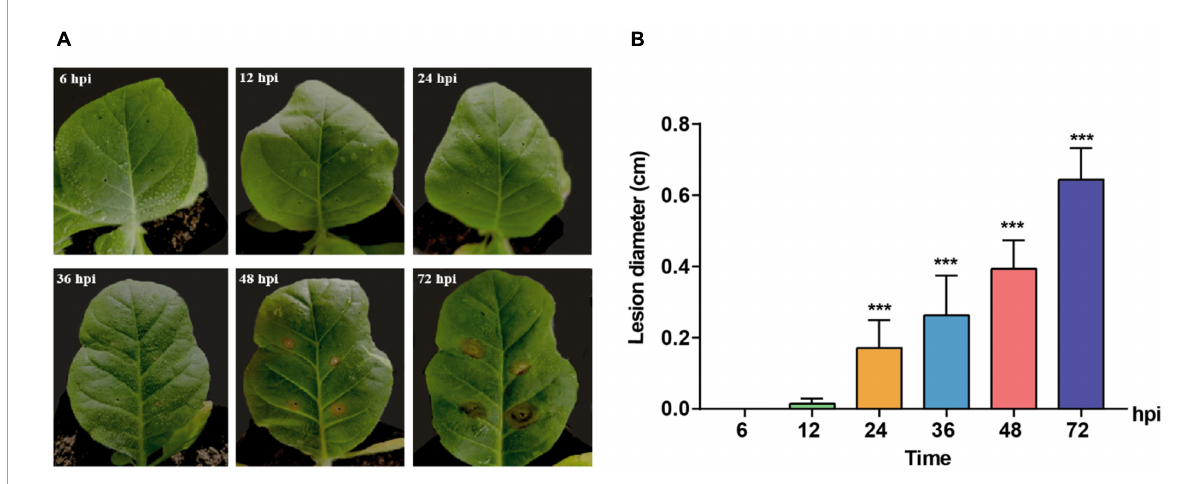
FIGURE1 Symptoms change of Nicotiana tabacum inoculated with R solani AG-3 TB strain at different infection stages. (A) The symptoms on the Yunyan 87 leaf at 6, 12, 24, 36, 48, 72 hours post inoculation (hpi), respectively. (B) Measurement of the lesion diameter (cm) at 6 (control), 12, 24, 36, 48, 72 hpi. The asterisks show the statistical significances using the two-tailed t -test (* p < 0.05, ** p < 0.01, *** p < 0.001).